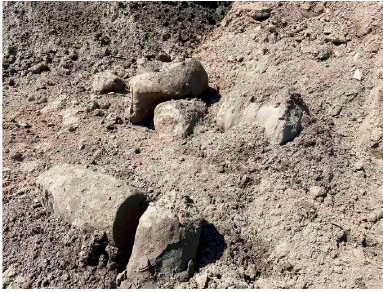
Figure 17. Excavation site of test piles.